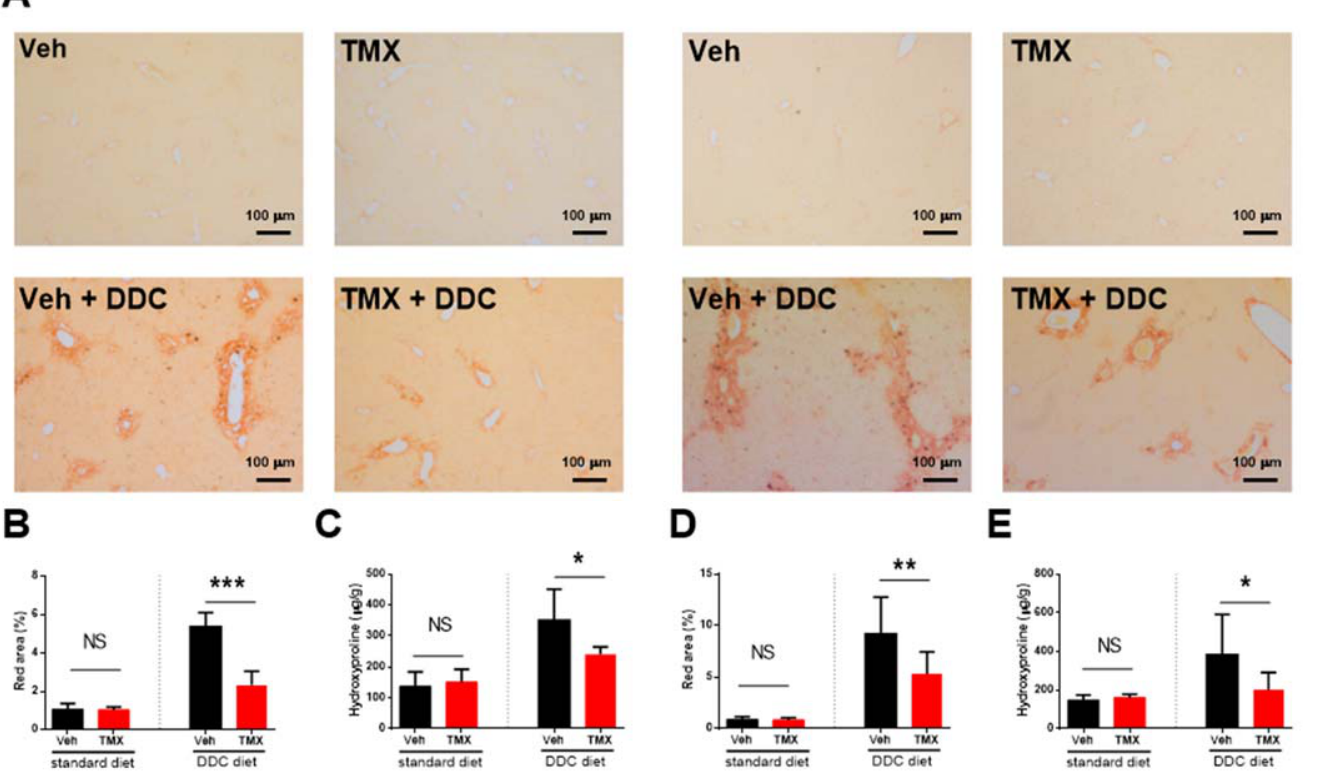
Figure 1. Tamoxifen ameliorates DDC ‐ induced fibrosis. Male or female mice were fed standard or DDC ‐ supplemented diet as indicated, and treated with vehicle (black bars) or tamoxifen (red bars). Light microscope photograph of representative Sirius red ‐ stained liver section for each group is shown ( A ). Red area was quantified using Image J software and hydroxyproline content was determined in liver tissue using the commercially available kit ( B–E ). Data represent mean + SD, Student’s t ‐ test was used for comparison between the groups, * p < 0.05, ** p < 0.01, *** p < 0.001, NS—